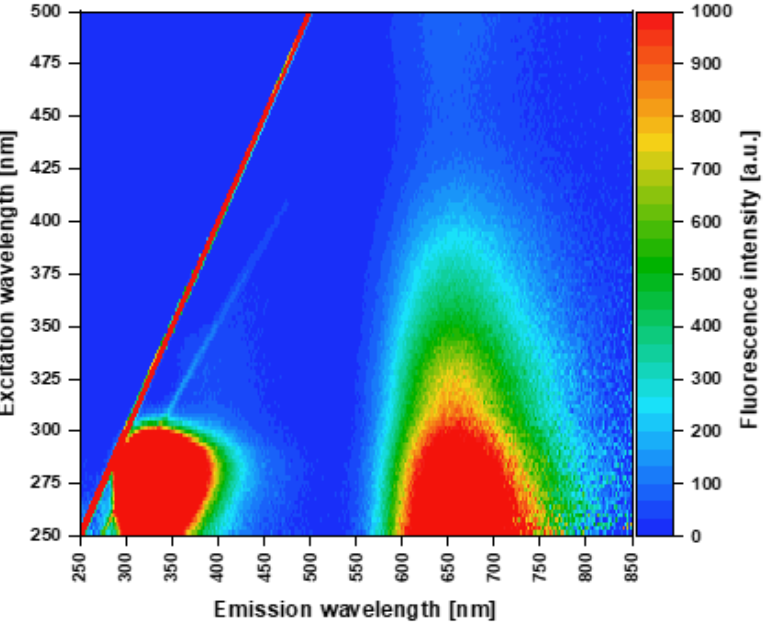
Figure 1. Fluorescence 3D excitation-emission map of AuBSA. Note: Strong Rayleigh (red line) and weak Raman (blue line) scattering first-order maxima are visible as straight lines in the map and represent artifacts that do not belong to AuBSA.